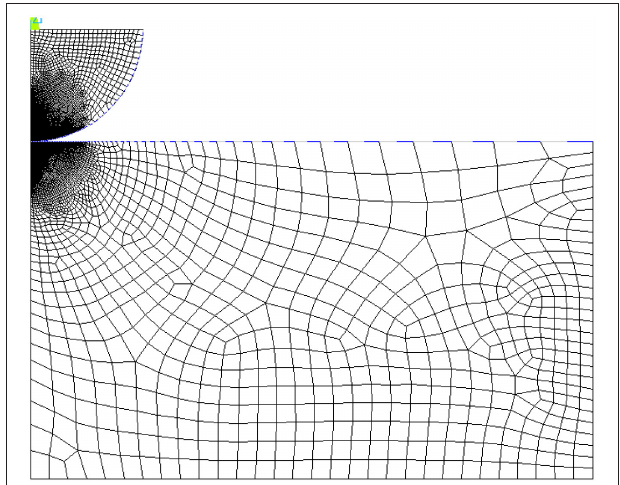
FIGURE 1 | Finite element mesh for contact between a purely elastic sphere and a bilinear plastic